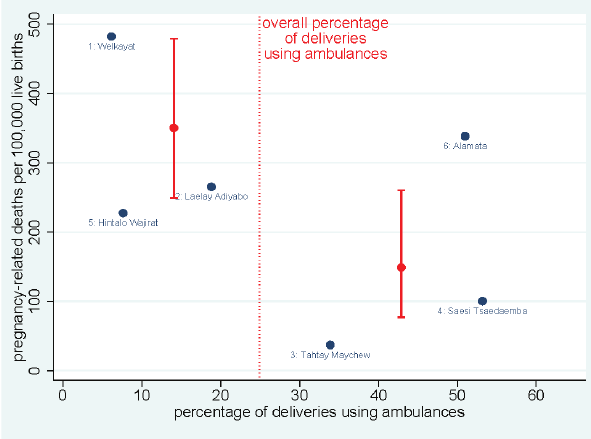
Figure 3. Maternal mortality ratios (MMR) and proportions of deliveries using ambulances for each District. Red bars indicate aggregated MMRs and 95% confidence intervals for Districts achieving above and below the overall percentage (24.9%) of deliveries using ambulances.